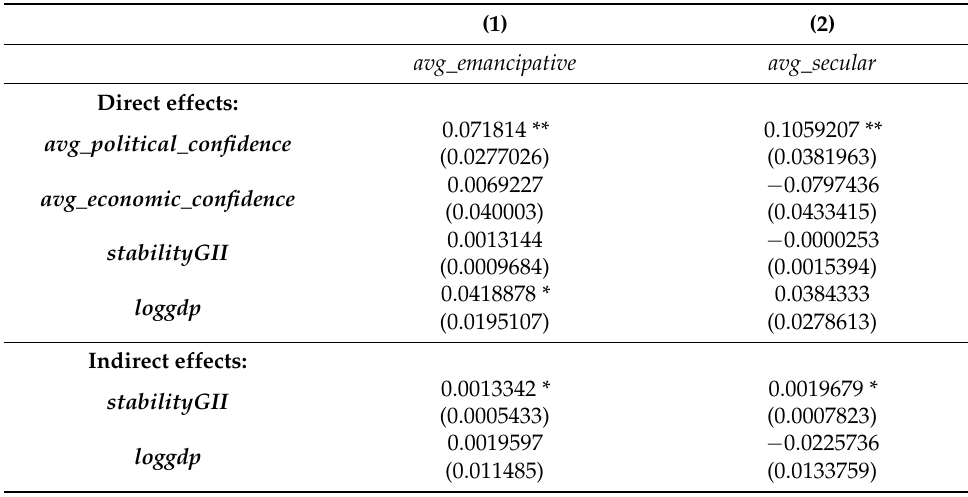
Figure 3. SEMs for secular values. Note: Solid lines are used to denote significant paths. Table 5. Mediation analyses of secular and emancipative